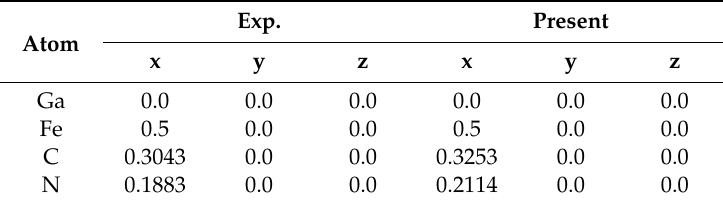
Table 1. Atomic occupied positions in GaFe(CN) 6 .